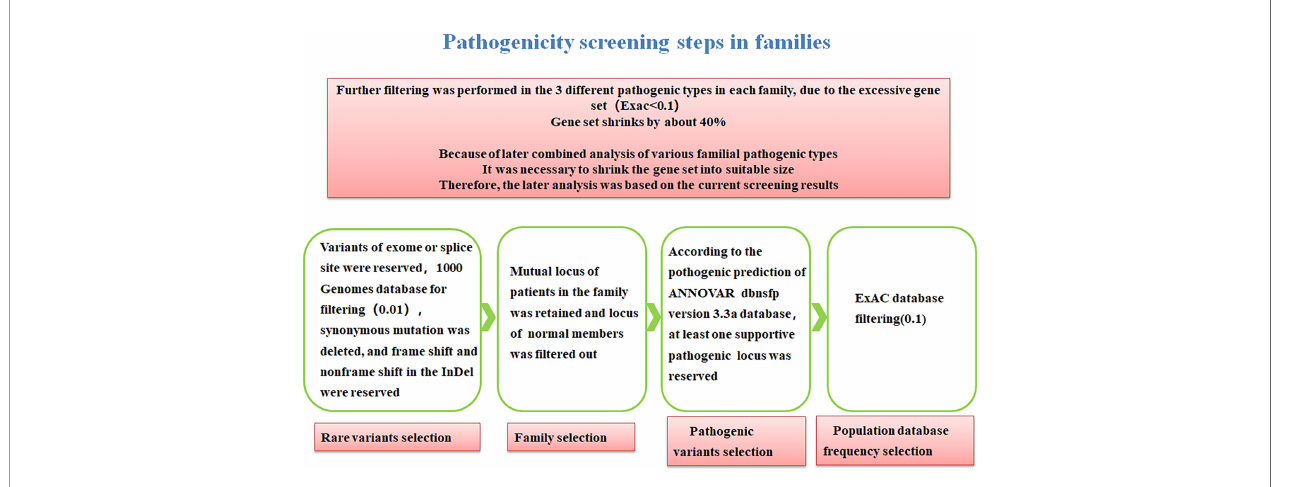
FIGURE 2 | Procedure of common-speci fi c